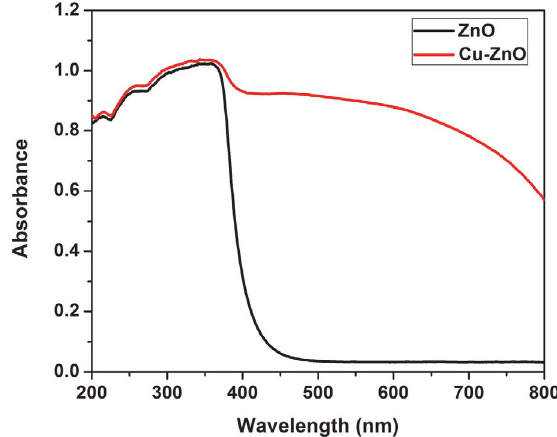
Figure 1. UV-Vis DRS spectra of ZnO and Cu-ZnO NPs